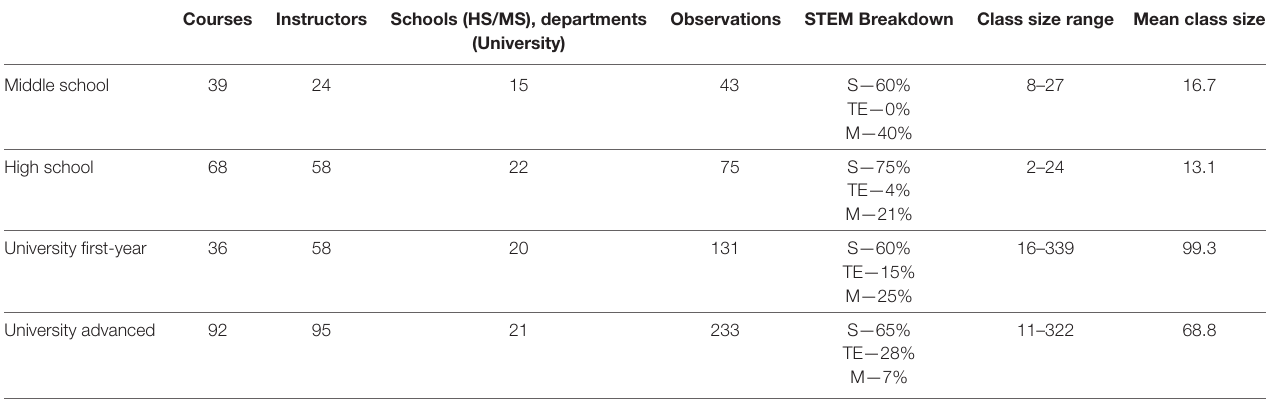
Table 1 | Demographic information about all the secondary and university courses